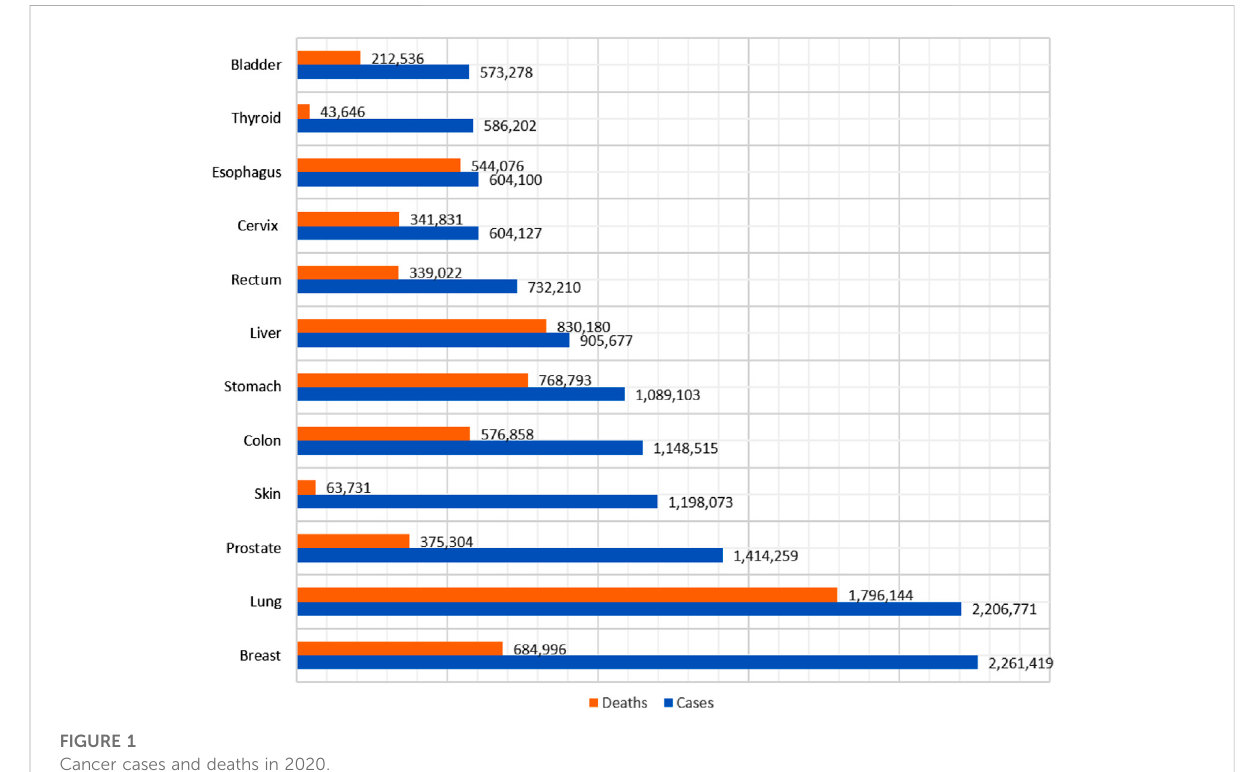
FIGURE 1 Cancer cases and deaths in 2020.